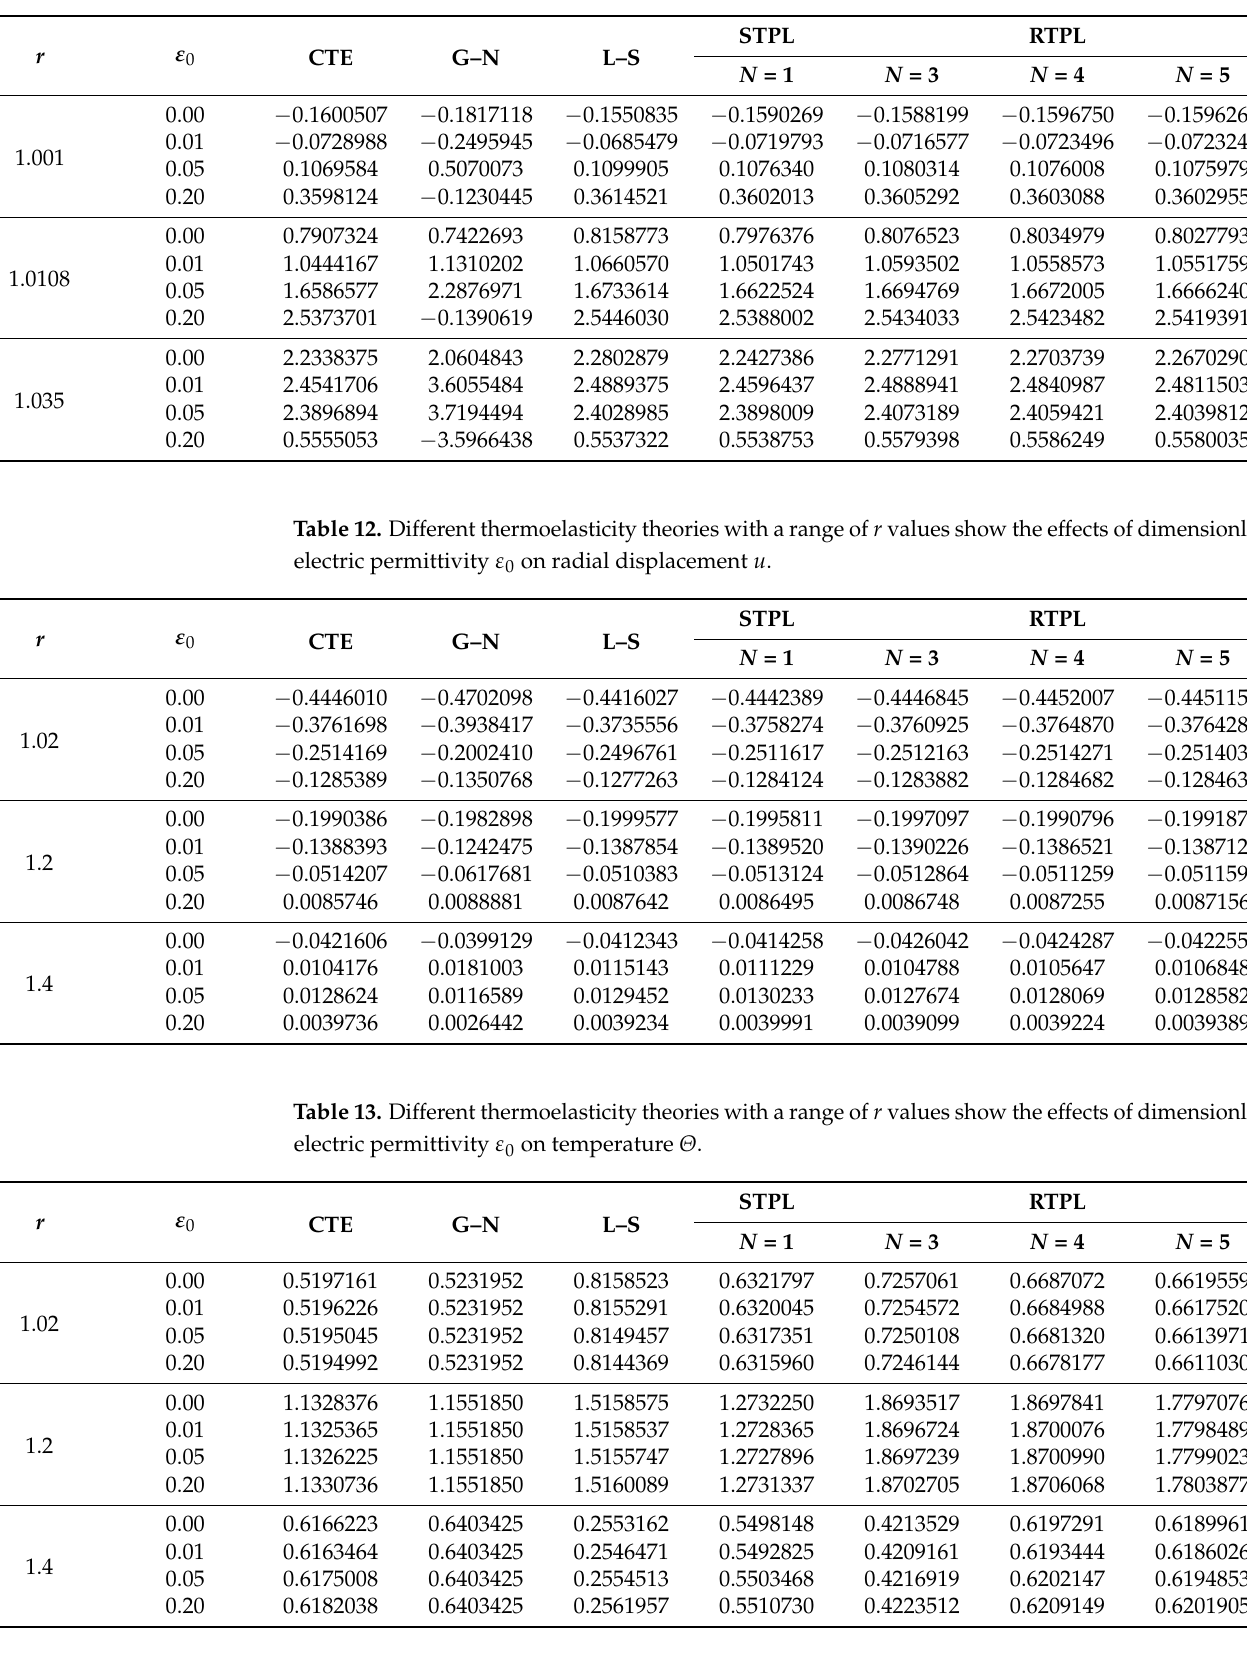
Table 11. Different thermoelasticity theories with a range of r values show the effects of dimensionless electric permittivity ε 0 on volumetric strain e .